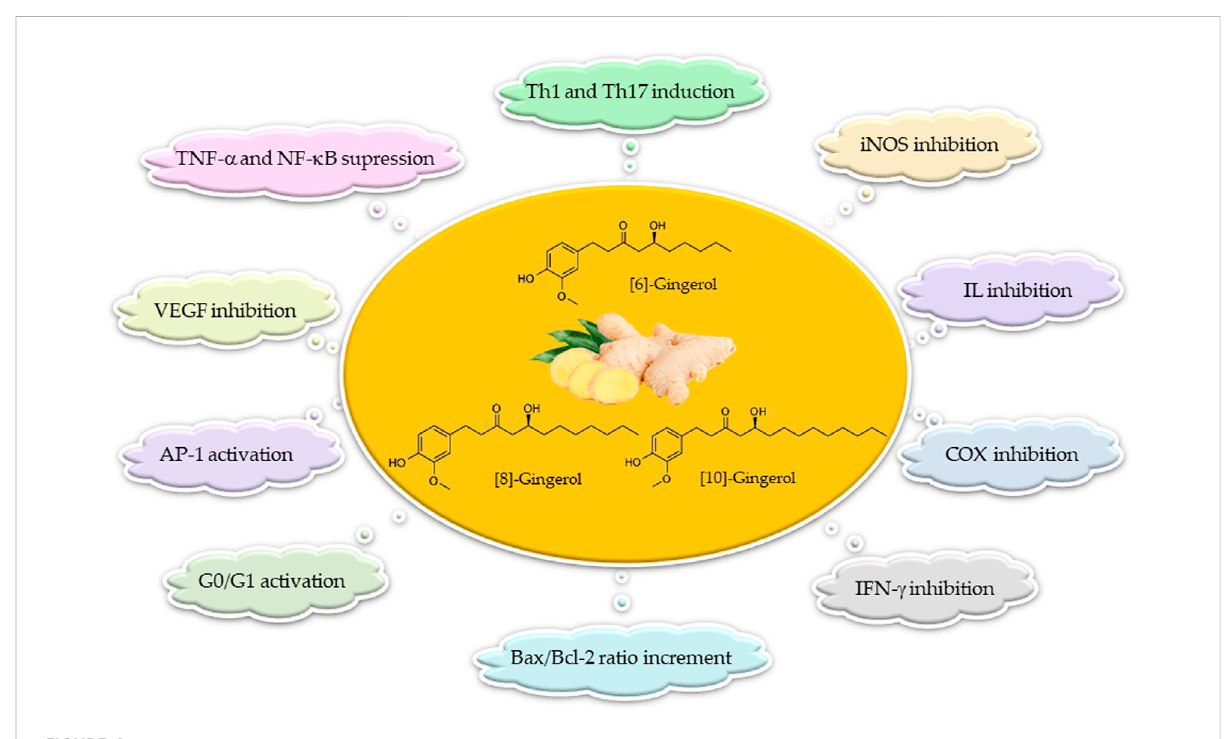
FIGURE 4 Molecular mechanisms in the immunomodulating activity of